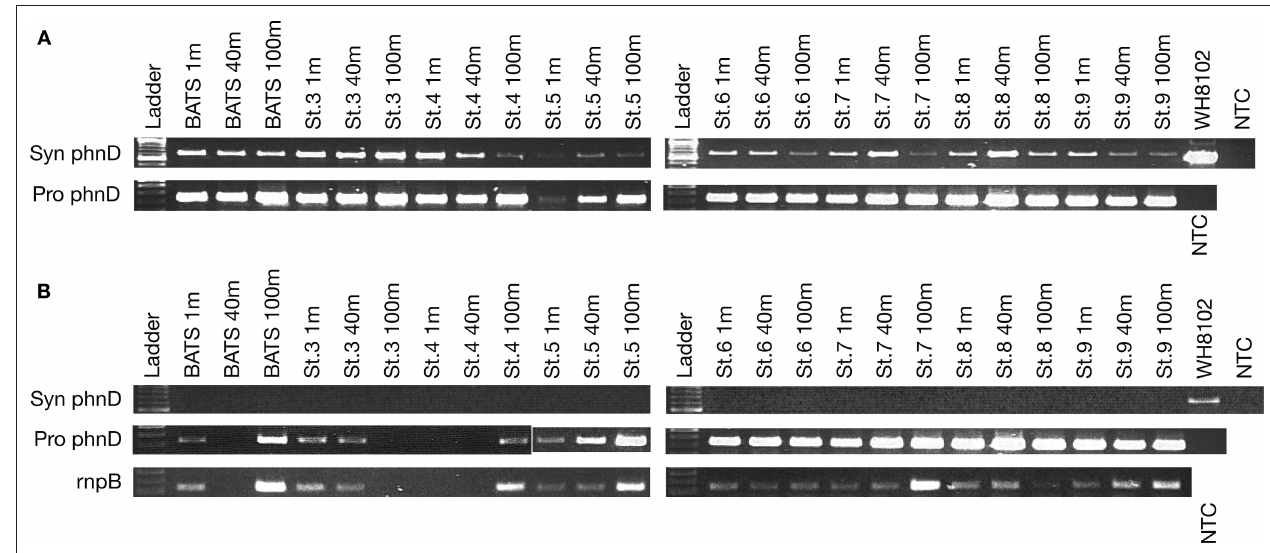
FIgure 2 | (A) PCR of Synechococcus and Prochlorococcus spp. phnD from the Sargasso Sea samples taken in at several stations during May 2008. The mixed layer was 80 m, and the DCM was at 100 m. (B) , top rows: RT-PCR of